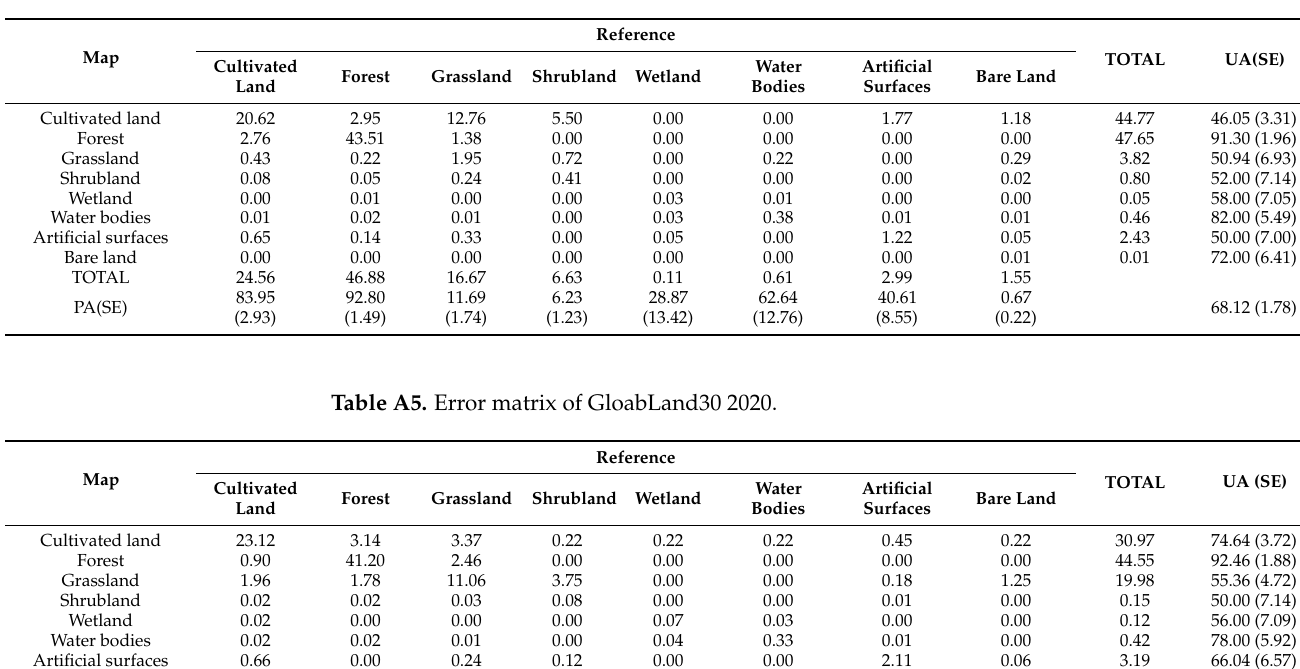
Table A4. Error matrix of FROM_GLC 2010.